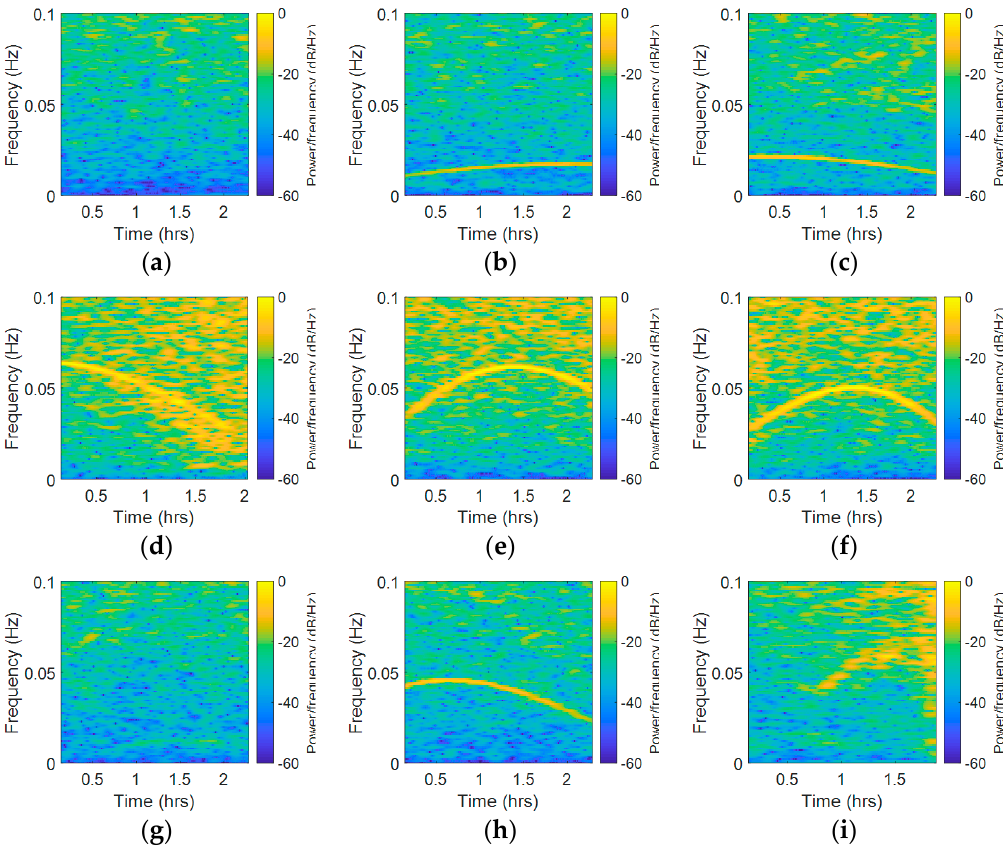
Figure 13. STFT results of Dataset 4, observed on 27 October 2016, Site A, ( a ) C01, ( b ) C06, ( c ) C08, ( d ) R04, ( e ) R05, ( f ) R20, ( g ) G02, ( h ) G05, and ( i ) G06. R04, ( e ) R05, ( f ) R20, ( g ) G02, ( h ) G05, and ( i )